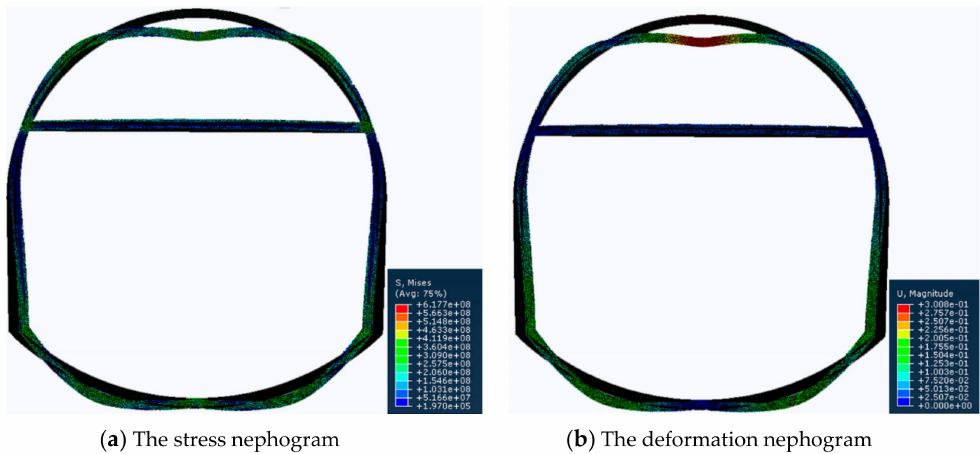
Figure 12. The stress nephogram and the deformation nephogram of RB set